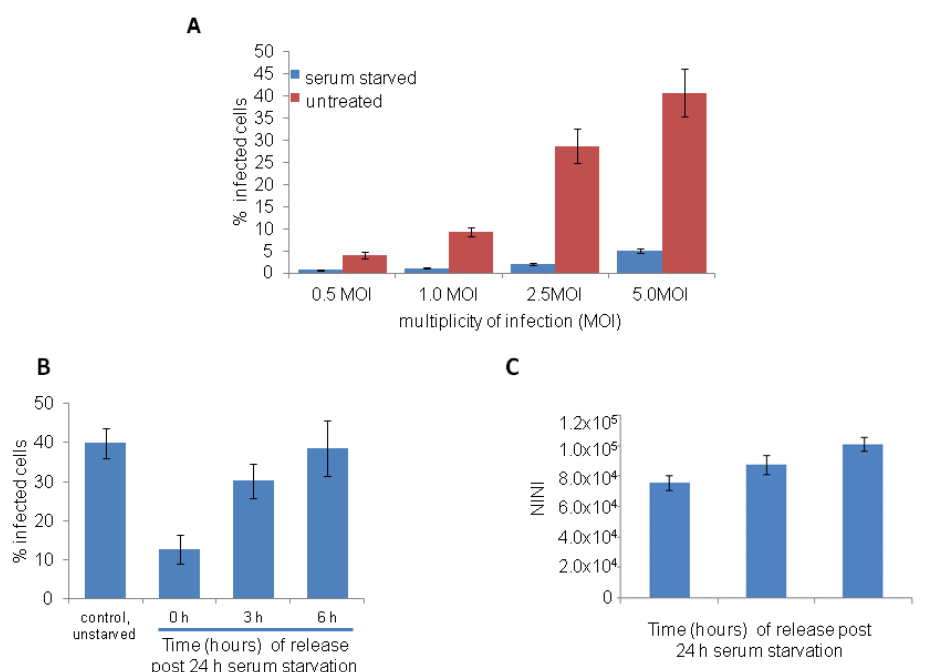
Figure 2. Ebola virus (EBOV) infection is restricted in serum starved HeLa cells. ( A ) HeLa cells were serum starved for 24 h and then infected with different MOI of EBOV for 24 h in complete medium. Cells were stained with anti-GP antibody (6D8) and imaged. Image analysis showed reduced EBOV infection in serum starved cells compared to control cells. ( B , C ) HeLa cells were serum starved for 24 h and then infected at 0, 3 h and